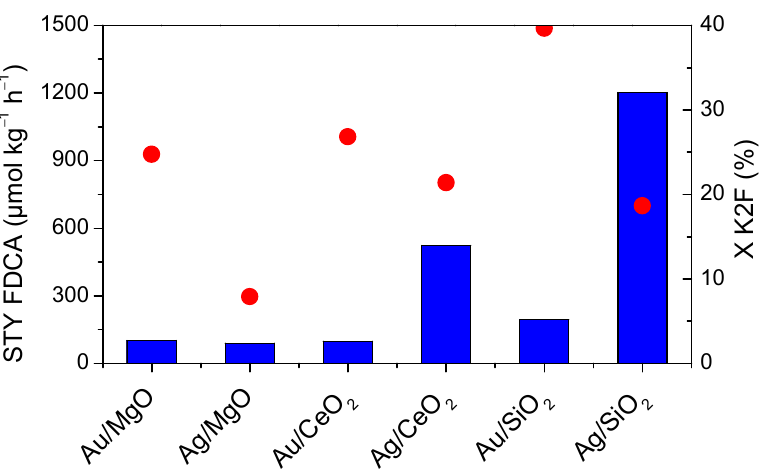
Figure 3. Effect of the support on gold and silver catalysts in the K2F carboxylation: K2F conver- ( • ) and the STY of 2,5-FDCA ( (cid:4) ) (Conditions: Substrate/M = 9, F CO sion ( ● ) and the STY of 2,5-FDCA ( ■ ). (Conditions: Substrate/M = 9, F CO2 = 45 mL min − 1 , 20 rpm, T = 200 °C, t = 20 h.) T = 200 ◦ C, t = 20